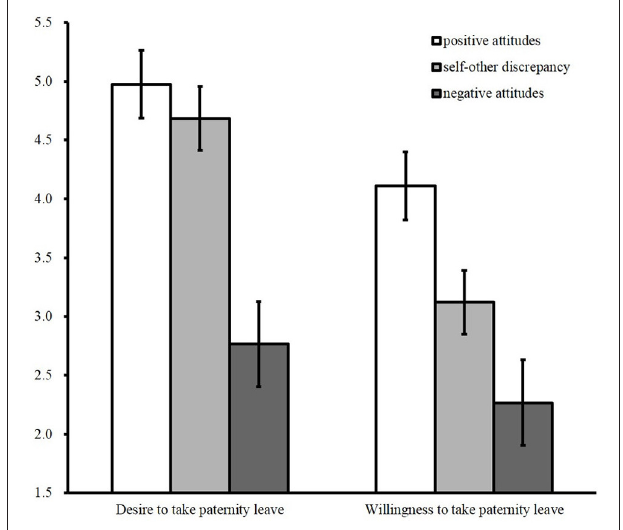
FIGURE 1 | Means of behavioral intentions by group in Study 1 (error bars are 95% confidence intervals).